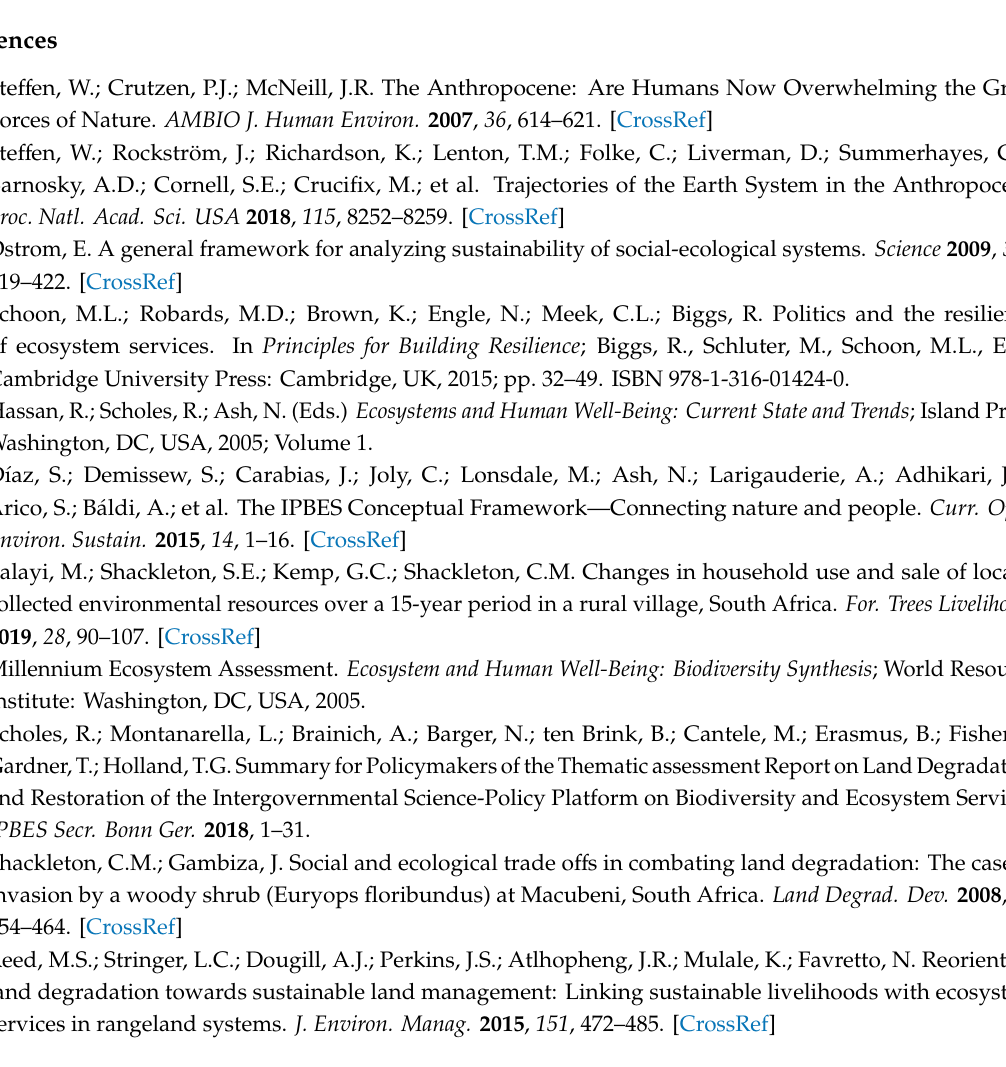
Table S1: Design principles, interpretations, application in the Machubeni Case Study; Table S2: Actor groups identified as members of the transformative space (Masibambisane multi-actor Forum); Table S3: Centrality measures i.e., in-degree and betweenness over time (common goals); Table S4: Centrality measures i.e., in-degree and betweenness over time (information-sharing network); Table S5: Centrality measures i.e., in-degree and betweenness over time (Inter-organisational trust